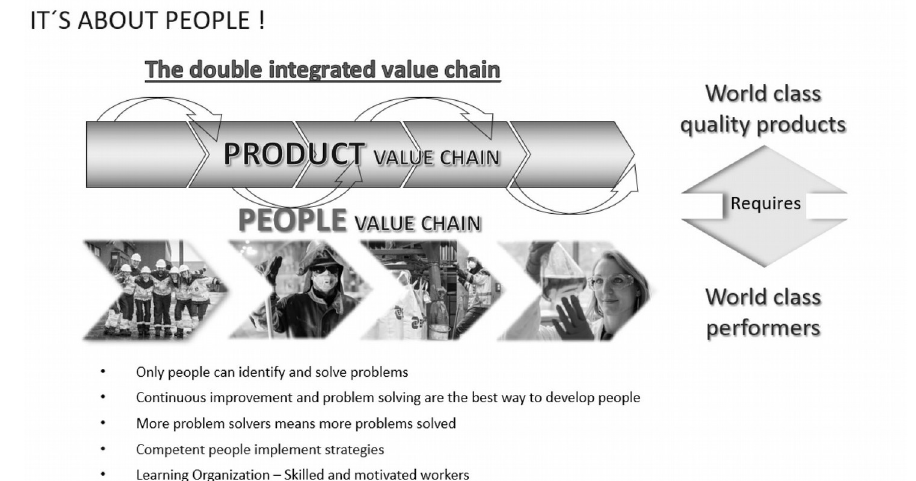
Figure 1. The corporate XPS: ‘It’s about